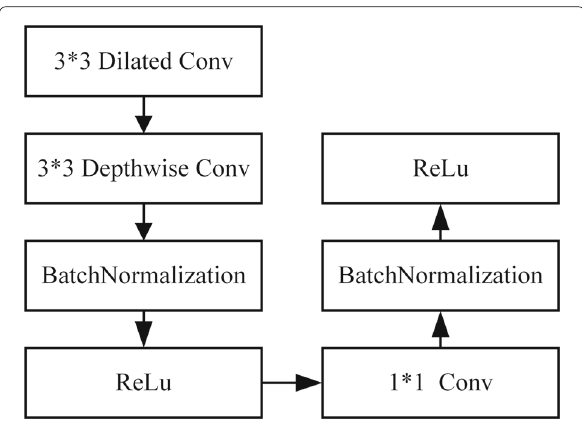
Fig. 5 Structural flow chart